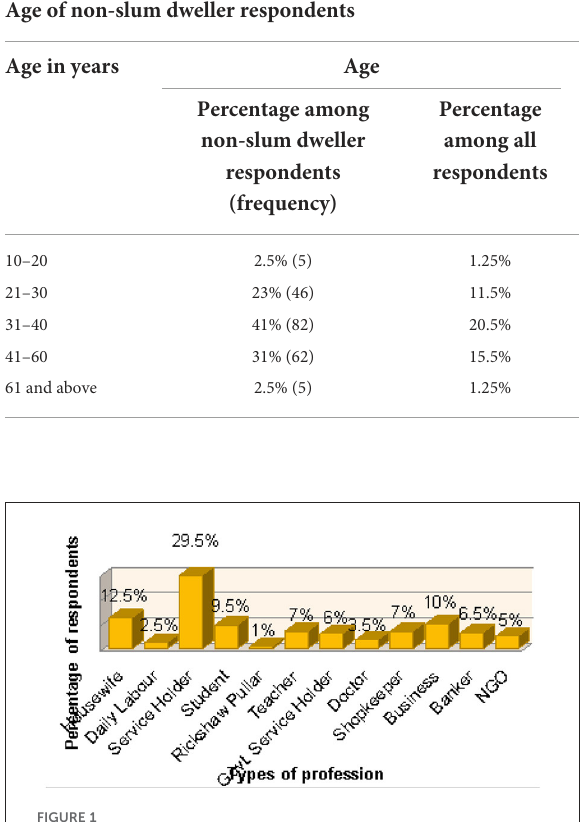
FIGURE1 Profession of non-slum dweller questionnaire respondents.